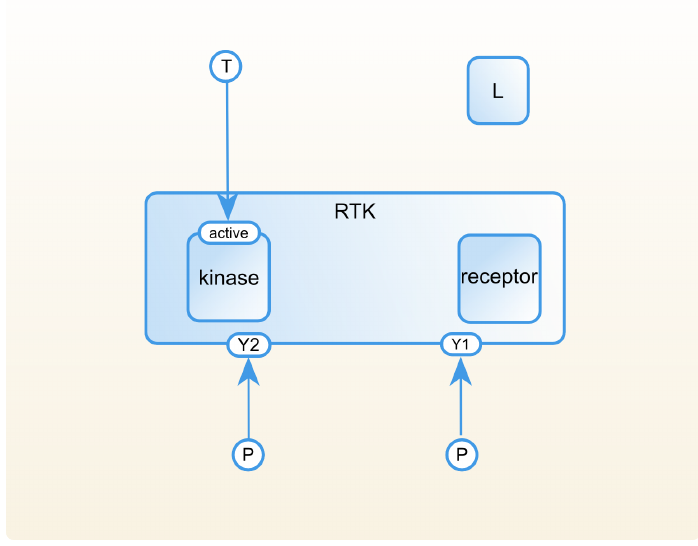
Figure A.2: Receptor tyrosine kinase activation: state variable assignment.